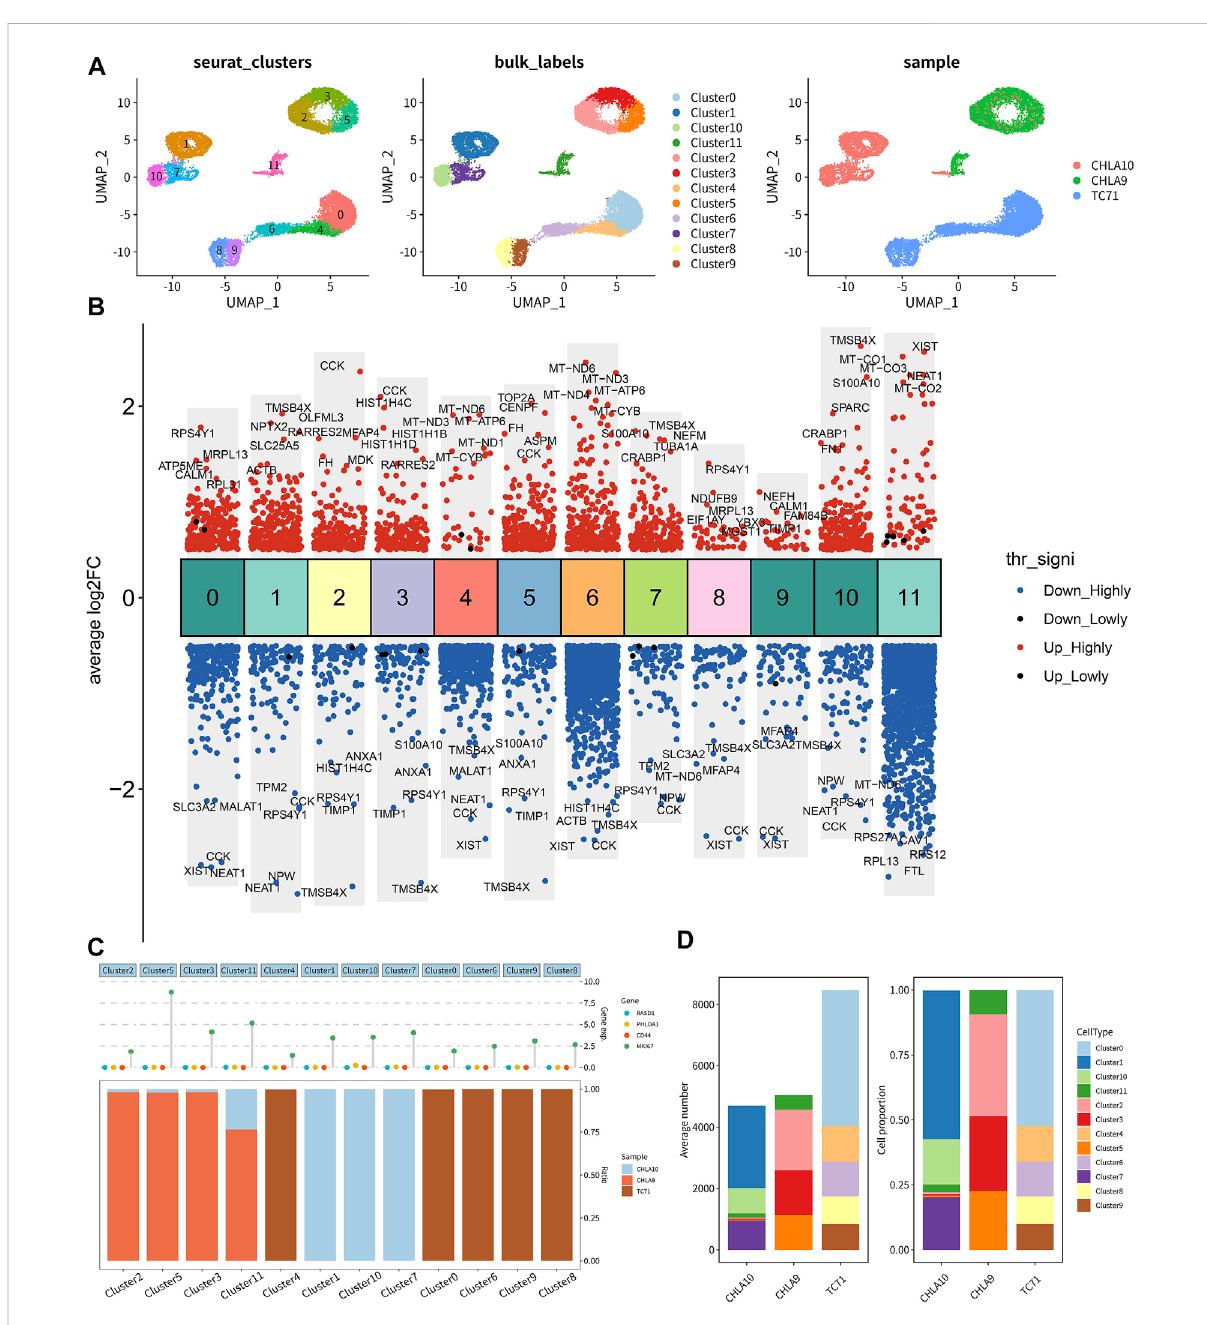
FIGURE 8 Single-celltranscriptomic analysis of Ewingsarcomacelllines. (A) The distributionof12 clustersin3Ewing sarcoma cell lines (CHLA9, CHLA10, and TC71). (B) Gene co-expression of top 5 genes in clusters. (C) Signi fi cantly up- or down-regulated genes in clusters. (D) Cell number and cell proportion of 12 clusters in 3 cell